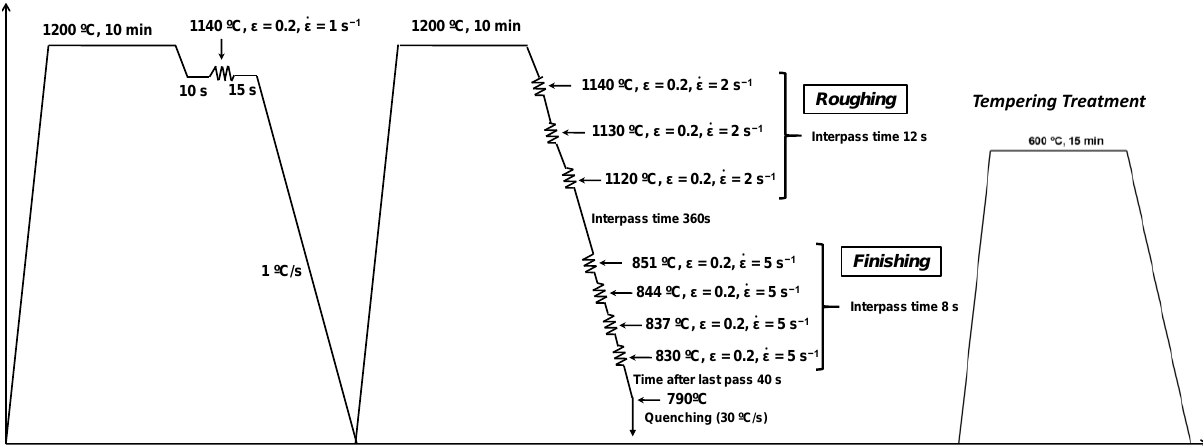
Figure 1. Schematics of the applied plane strain compression cycle.